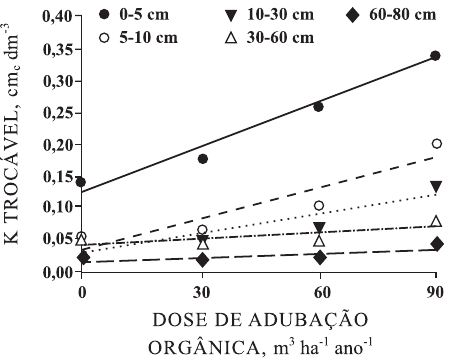
Figura 2. Teores de K + em sistema plantio direto submetido à adubação com diferentes doses de esterco líquido de gado leiteiro, durante